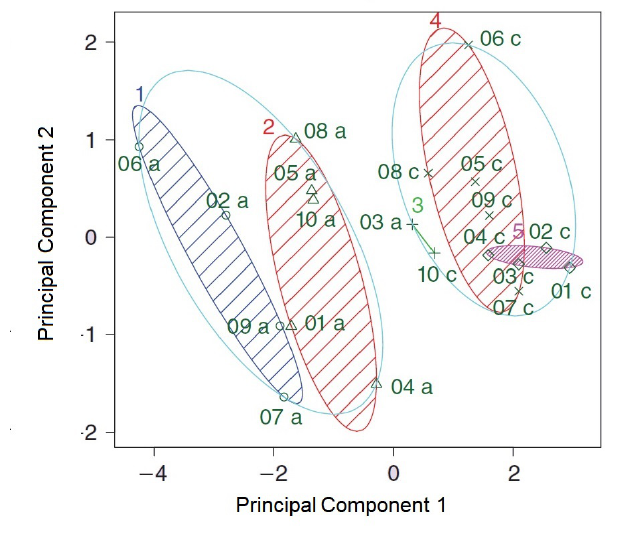
Figure 10. Driving style Lap clustering